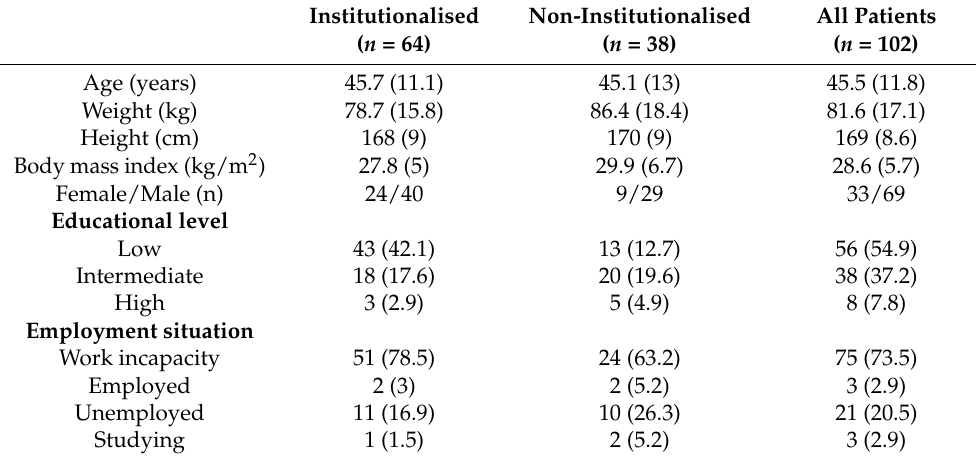
Table 1. The general characteristics of the participants before the COVID-19-related